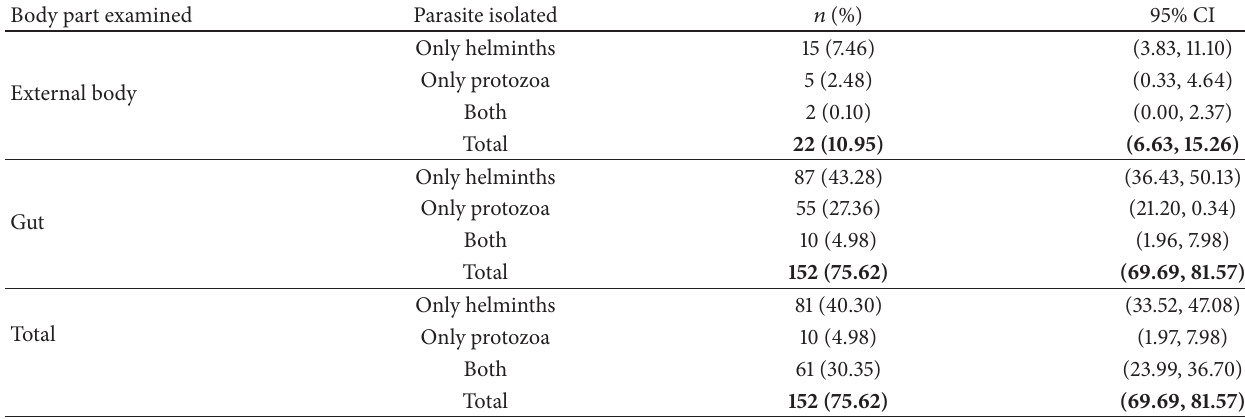
Table 2: Percentage of parasites isolated from the gut contents and external body surfaces of the populations of B. germanica in Jimma Town, southwestern Ethiopia,